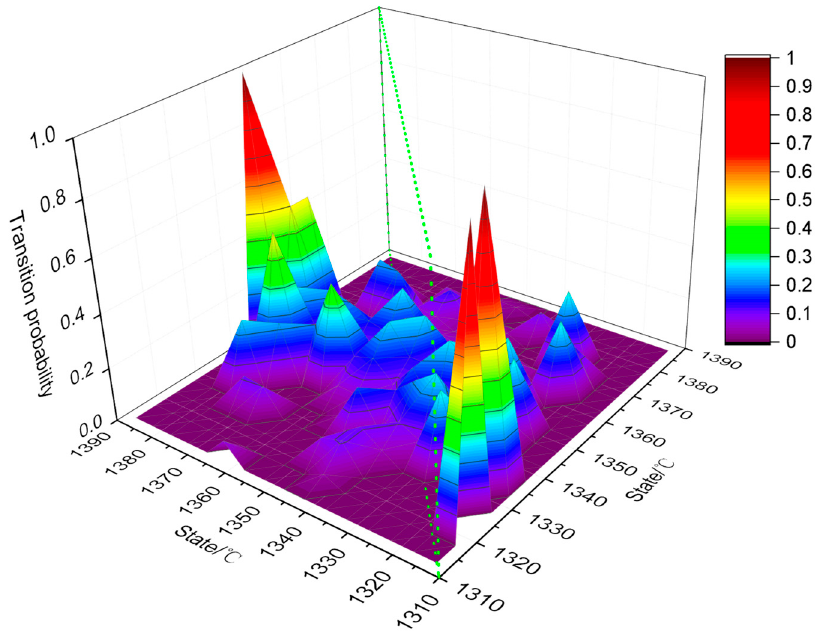
Figure 3. Graphical representation of the Markov transition matrix.